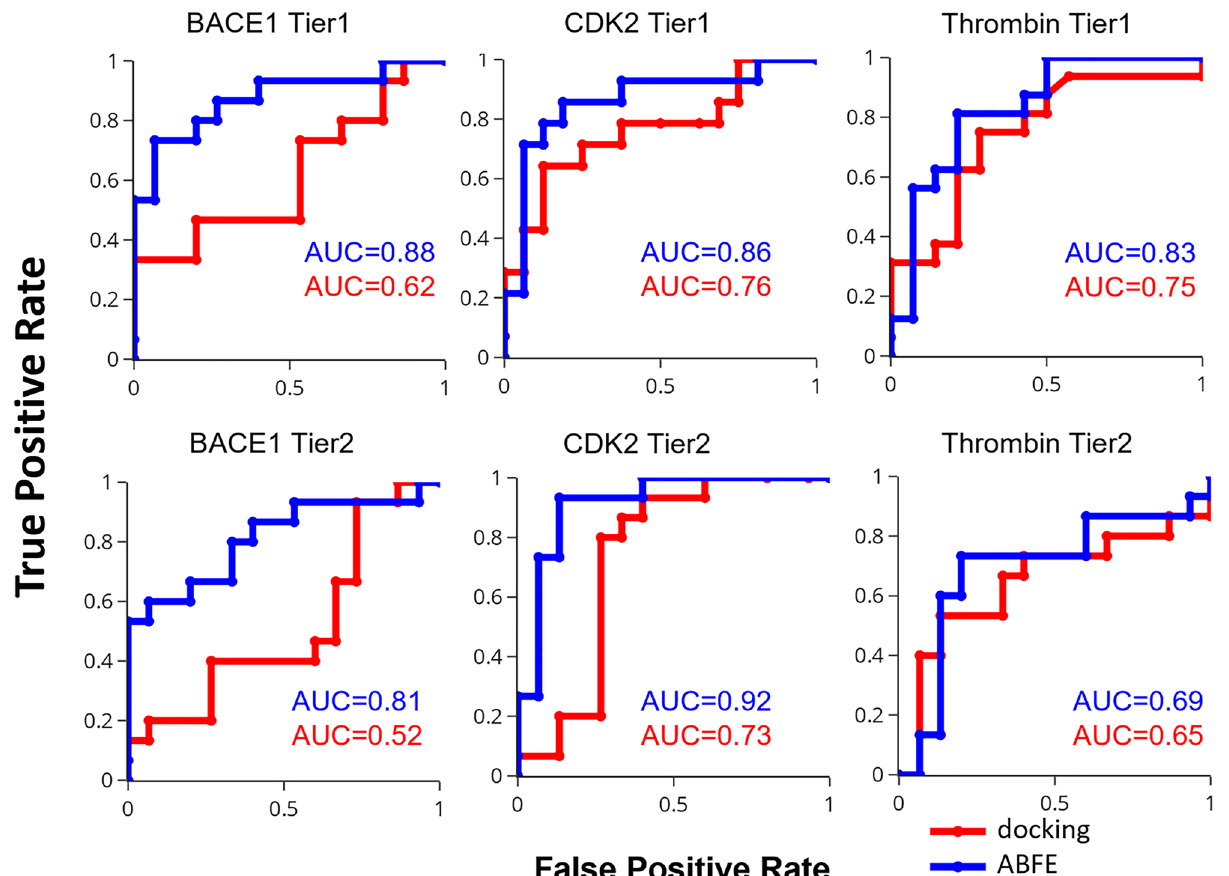
Figure 1. Comparison of the ability of ABFE calculations versus docking to distinguish active compounds from inactives (decoys), shown as Receiver Operating Characteristic (ROC) curves with the Area Under Curve (AUC) statistics for the 30 Tier 1 and 30 Tier 2 compounds of all three protein targets, as labeled. Red: docking results. Blue: ABFE results. These ABFE calculations omit the free energy term for ligand protonation